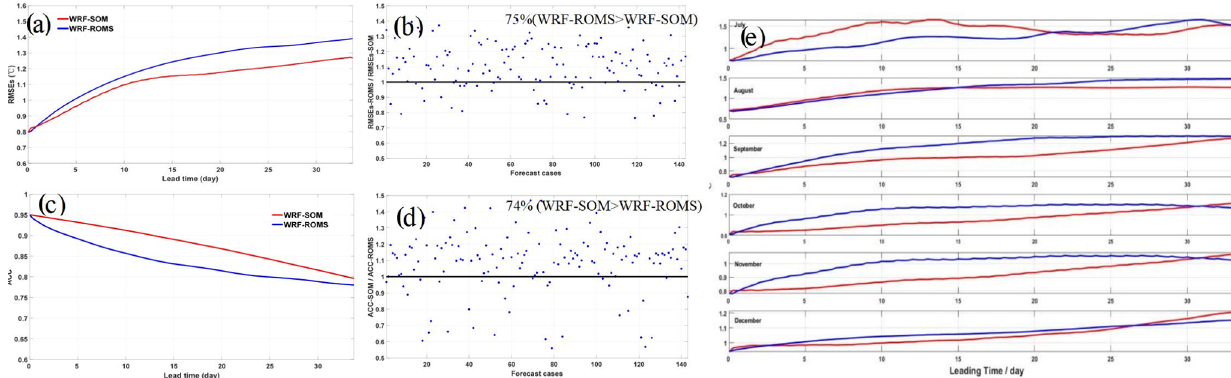
Figure 2. Time series of (a) averaged root mean square errors (RMSEs), (c) anomaly correlation coefficients (ACCs), and (e) averaged RMSEs over different seasons of simulated sea surface temperatures (SSTs) against Hybrid Coordinate Ocean Model (HYCOM) reanalysis of total 142 forecast cases from 19 July to 31 December 2020. The comparison of the (b) RMSEs, and (d) ACC between WRF-SOM and WRF-ROMS for each case.